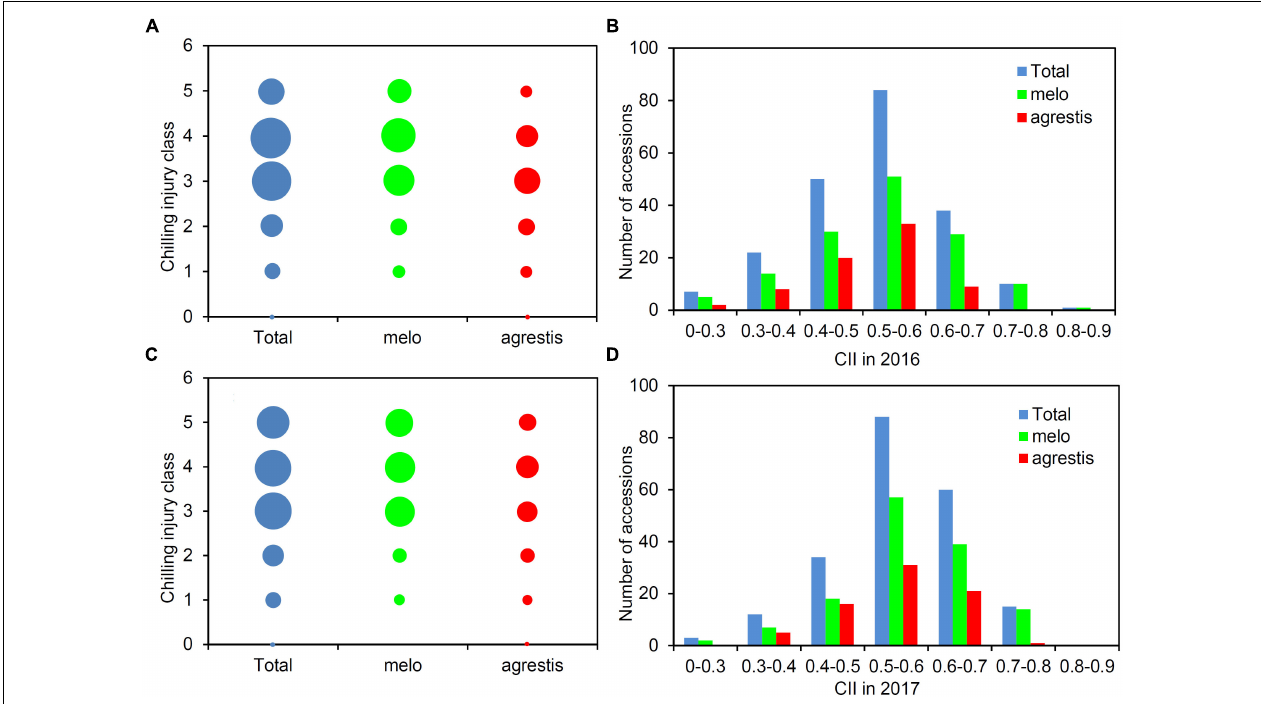
FIGURE 1 | Phenotypic structure of the melon panel in response to low-temperature treatment. Distribution of the number of accessions with different chilling injury classes among the total accessions, melo accessions, and agrestis accessions in 2016 (A) and 2017 (C) . Distribution of the number of accessions with CIIs among the total accessions, melo accessions, and agrestis accessions in 2016 (B) and 2017 (D) .